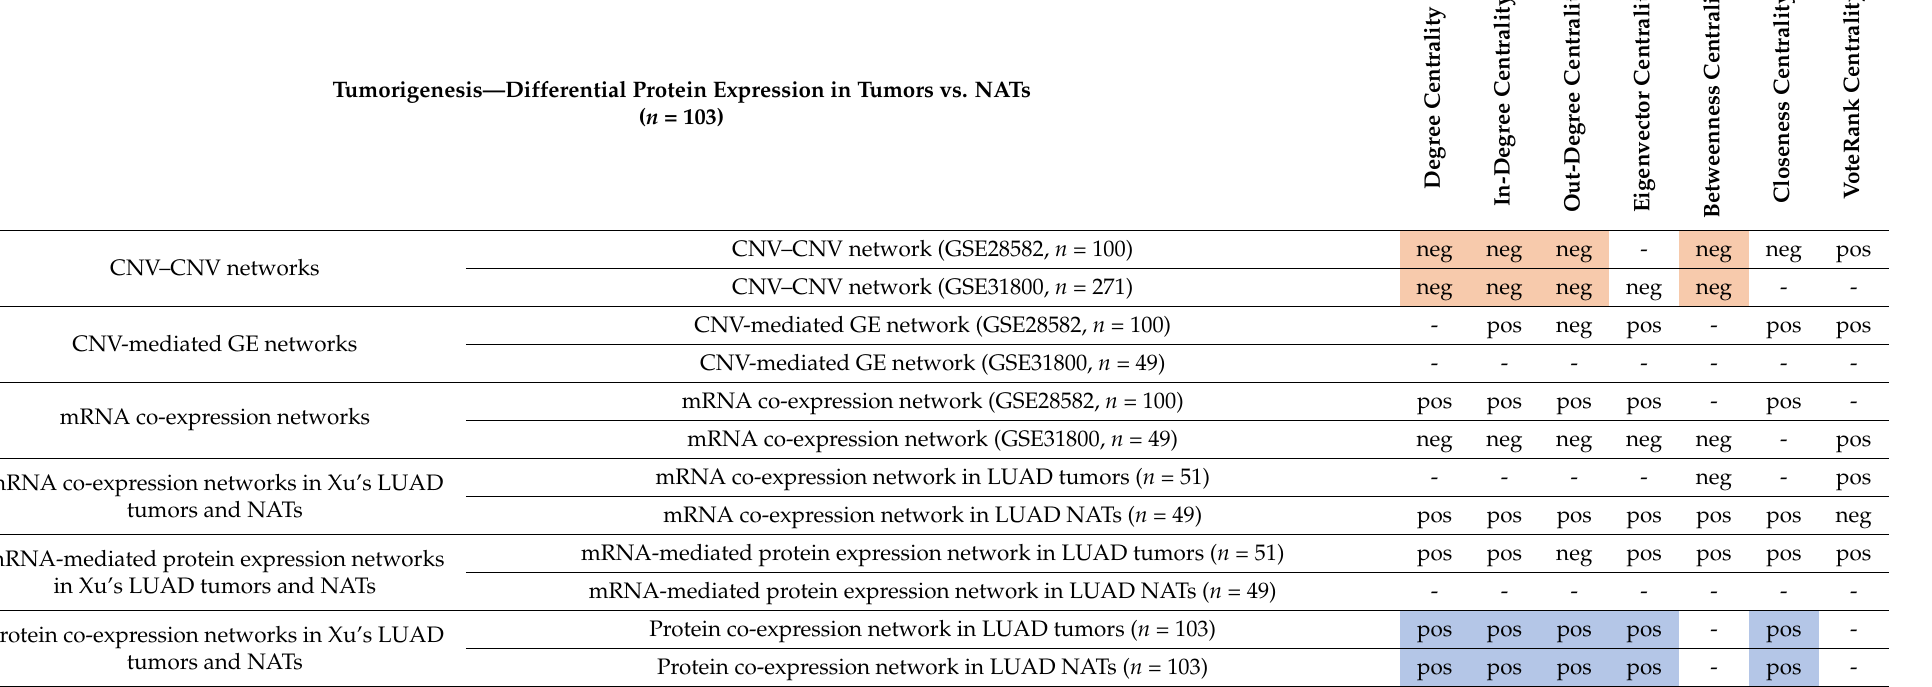
Table 3. Correlations between seven centralities of the selected networks and t statistics of differential protein expression in tumors vs. NATs in Xu’s LUAD cohort ( n = 103) [39]. pos: Pearson’s correlation coefficient r > 0 and p < 0.05; neg: r < 0 and p < 0.05. The blue color indicates concordant positive correlations. The orange color indicates concordant negative